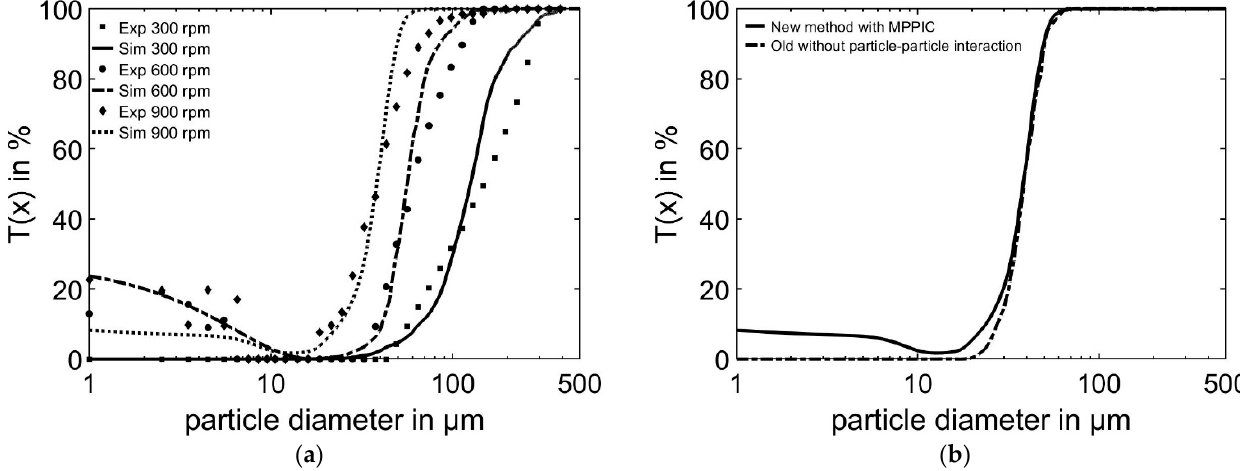
Figure 10. ( a ) Comparison of the experimentally measured and simulated collection efficiency with the new solver at three different classifier speeds; ( b ) comparison of the simulated collection efficiency with new method based on MPPIC and old version without particle-particle interaction at 900 rpm.